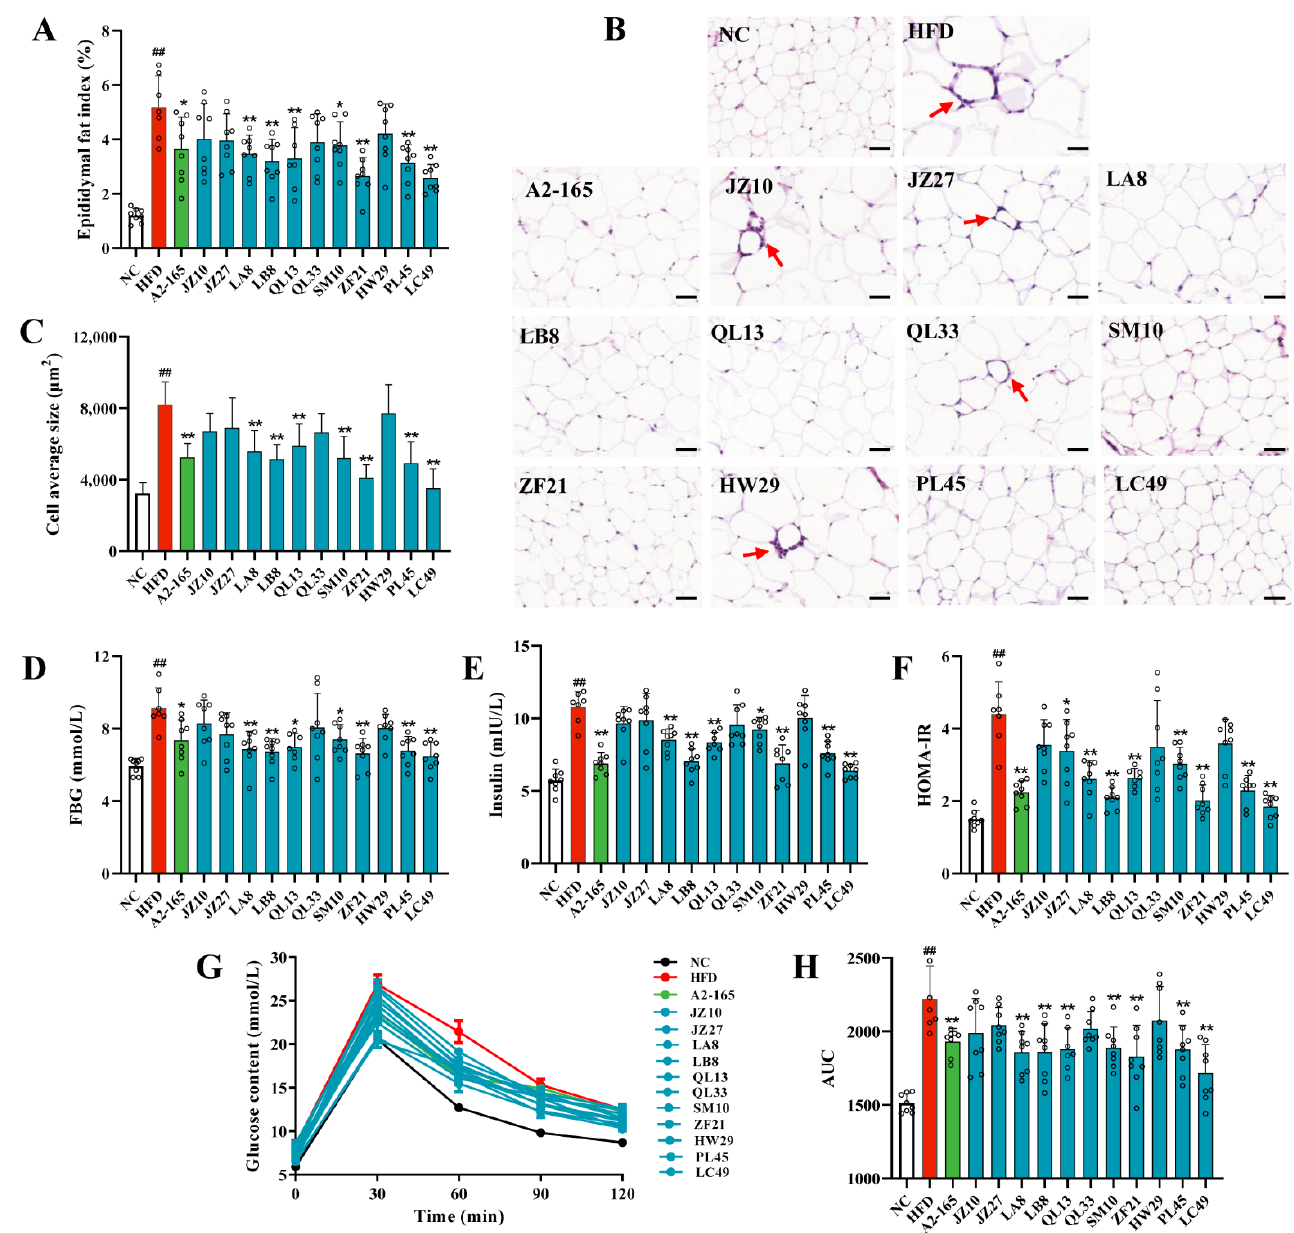
Figure 2. F. prausnitzii treatment reduced fat accumulation and improved insulin resistance in NAFLD mice. ( A ) Epididymal fat index; ( B ) Representative H&E staining of epididymal fat tissue (200 × , scale bars represent 50 μm, red arrow indicates inflammation); ( C ) Measurement of adipocyte cell sizes; ( D ) Fasting blood glucose (FBG) level; ( E ) Fasting insulin (FINS) level; ( F ) HOMA-IR index, FBG * FINS/22.5; ( G ) Means of blood glucose levels at 0, 30, 60, 90, and 120 min after oral gavage of 20 % ( w / v ) glucose (2 g/kg body weight); ( H ) Means of area under the concentration curve (AUC). Data are shown as means with SD; ## p < 0.01 vs. NC group, unpaired Student’s t -test; * p < 0.05, ** p < 0.01 vs. HFD group, one-way ANOVA followed by Dunnett’s test.